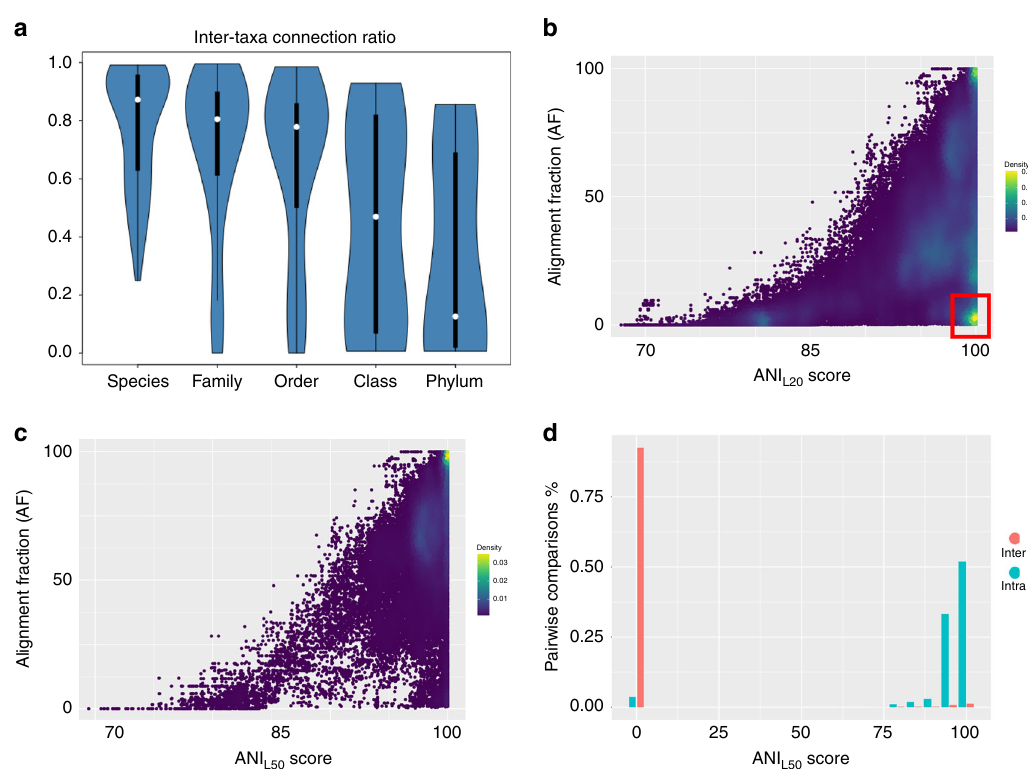
Fig. 2 Measuring plasmid similarity by AcCNET and ANI. a Plasmids of the same taxon tend to be more alike. Violin plots showing the ratio of trajectories between plasmids from different taxa in the AcCNET network of Fig. 1. A trajectory is de fi ned as a connection between a plasmid, a given HPC, and a second plasmid that also contains a member of the HPC. For each plasmid of each taxon considered, the ratio was obtained by dividing the number of trajectories linking plasmids hosted in different taxa (species, families, phyla … ) by the total number of trajectories of that plasmid. White dots indicate the median connection ratio of trajectories between plasmids, black bars correspond to the Q1-Q3 interquartile range. b Density plot of ANI L20 ( x -axis) and AF ( y -axis) values for pairwise comparisons between plasmids of the order Enterobacterales . The color code indicates the relative density of that particular ANI/AF area. Yellow areas correspond thus to more frequent ANI/AF scores. The red square highlights a high number of comparisons with ANI L20 > 90% but AF < 10, corresponding to plasmids sharing only a small fragment of their genome with high homology (e.g., transposons or insertion sequences). Separate comparisons for MOB + and MOB − plasmids with sizes higher and lower than 40 kb are shown in Supplementary Fig. 3. c Density plot of ANI L50 ( x -axis) versus AF ( y -axis). Yellow areas correspond to more frequent ANI/AF scores. As shown in the fi gure, the L50 threshold on the ANI algorithm eliminates the high ANI/low AF comparisons. d Histogram of ANI L50 scores obtained in comparisons between plasmids of the same PTU (blue) and between plasmids of different PTUs